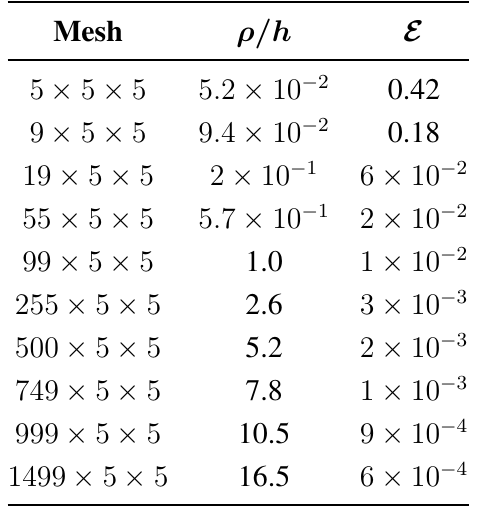
Table 4. Error for increasing ρ , fixed h = L/ 749 corresponding to the 749 × 5 × 5 mesh, inclination of the vertical discontinuity α = 0 ◦ ; the support width is ℓ